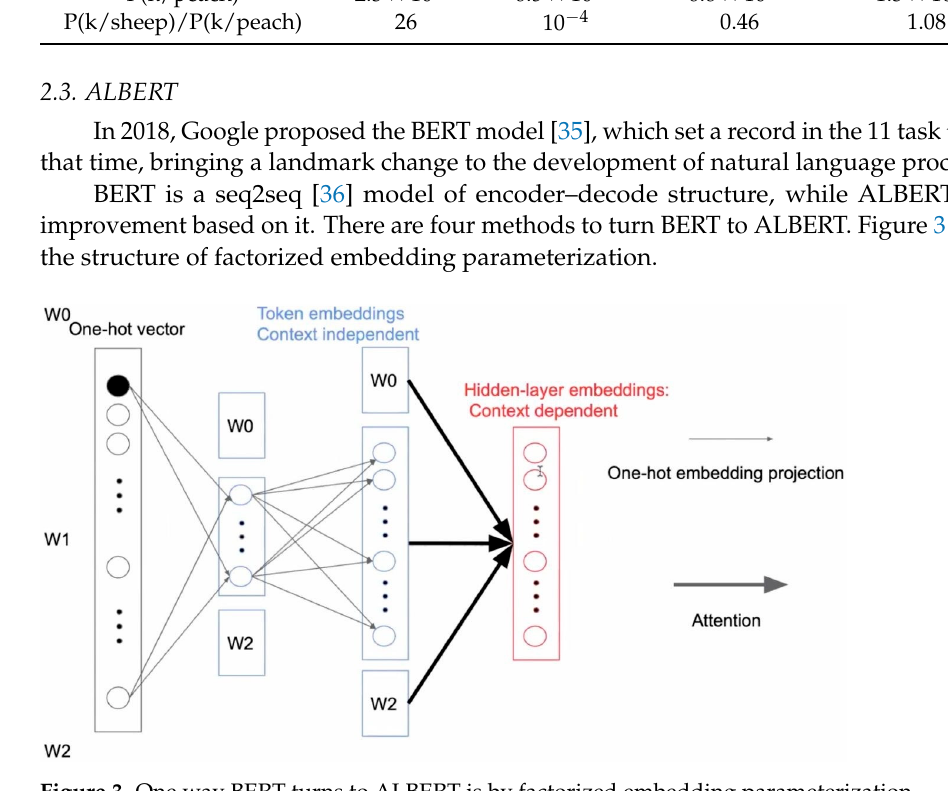
Figure 3. One way BERT turns to ALBERT is by factorized embedding parameterization.